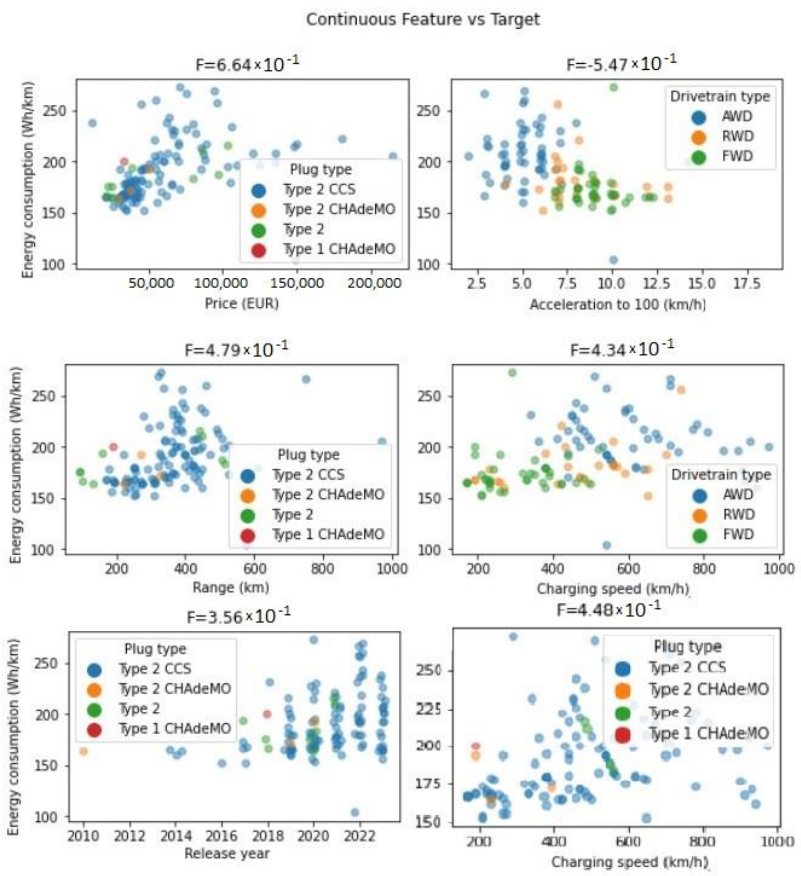
Figure 6. Selected continuous feature vs. energy consumption as a target.